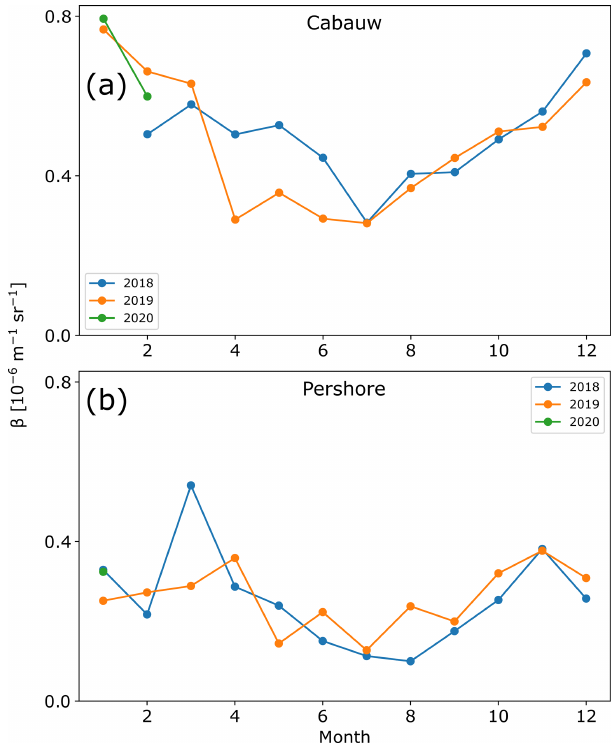
Figure 10. Monthly mean backscatter 39ma.g.l. (a) For Cabauw. (b) For